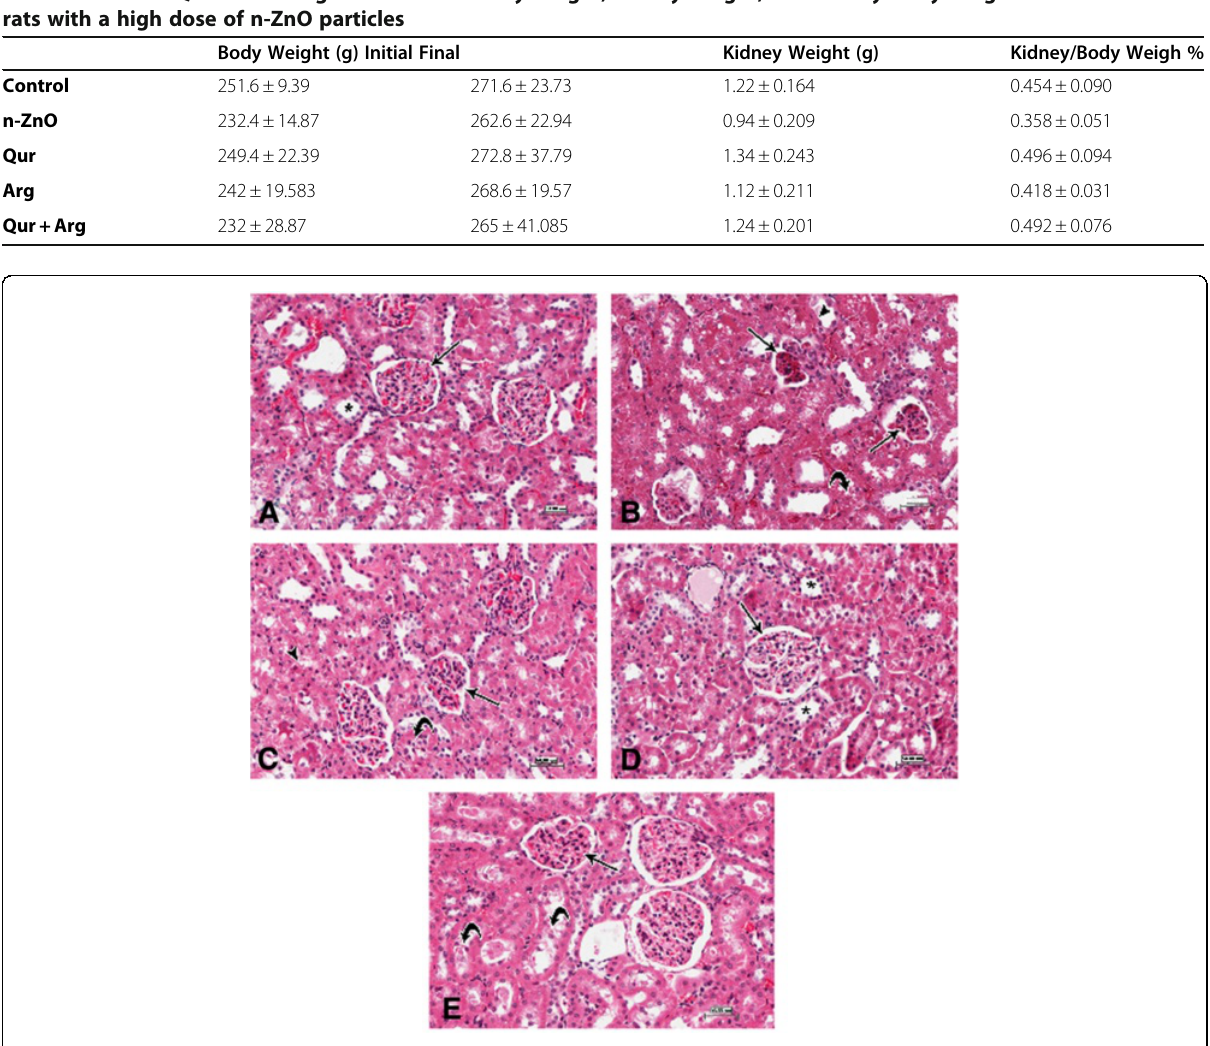
Figure 5 Photomicrographs of kidney sections stained with hematoxylin and eosin (scale bars=50 μ m), showing: (A) control group, normal architecture of renal corpuscles with their glomeruli (arrow) and renal tubules (asterisk); (B) intoxicated group with 600 mg/kg body weight/day n-ZnO particles for 5 days, shrinkage and fragmentation of many glomeruli (arrows) with many renal tubules showing degeneration, necrosis (arrowhead) and exfoliation of their lining epithelium (curved arrow); (C) Qur-treated group, shrinkage and fragmentation in many glomeruli (arrow) with necrosis (arrowhead) and exfoliation of lining epithelial cells of many renal tubules (curved arrow); (D) Arg-treated group, normal architecture of renal corpuscles with their glomeruli (arrow) as well as normal renal tubules (asterisk); and (E) Qur+Arg-treated group, few glomeruli with shrinkage and fragmentation, and few renal tubules with epithelial cell exfoliation (curved